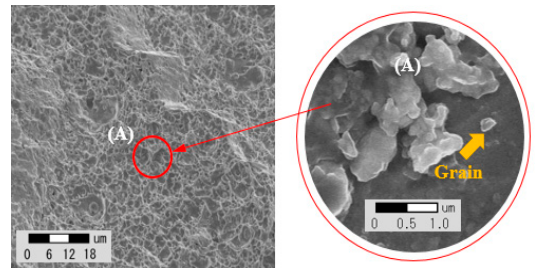
Figure 6. Definition of measurement section for weldment.